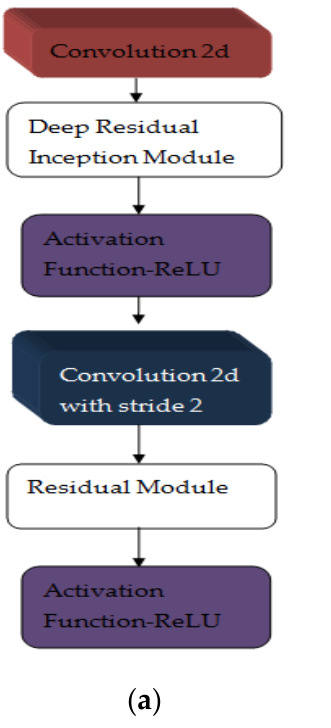
Figure 12. Part of AS-UNET.